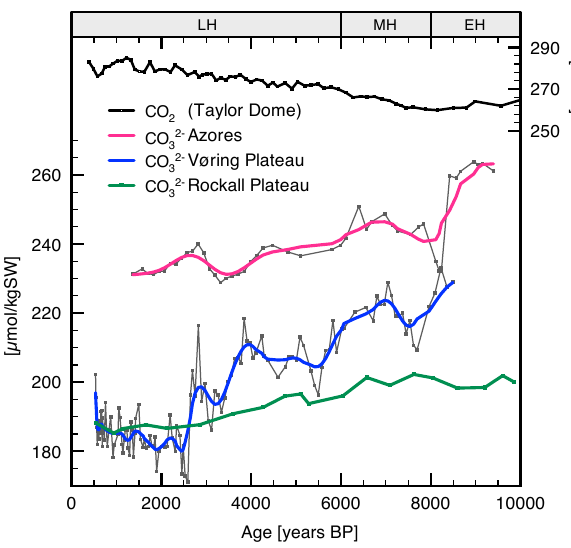
Fig. 4. Noelaerhabdaceae coccolith weights from core SU90-08 (Beaufort et al., 2011, black line) in comparison to Noelaerhab- daceae smoothed mean weight record from the Azores (red line), Rockall Plateau (green line) and Vøring Plateau (blue